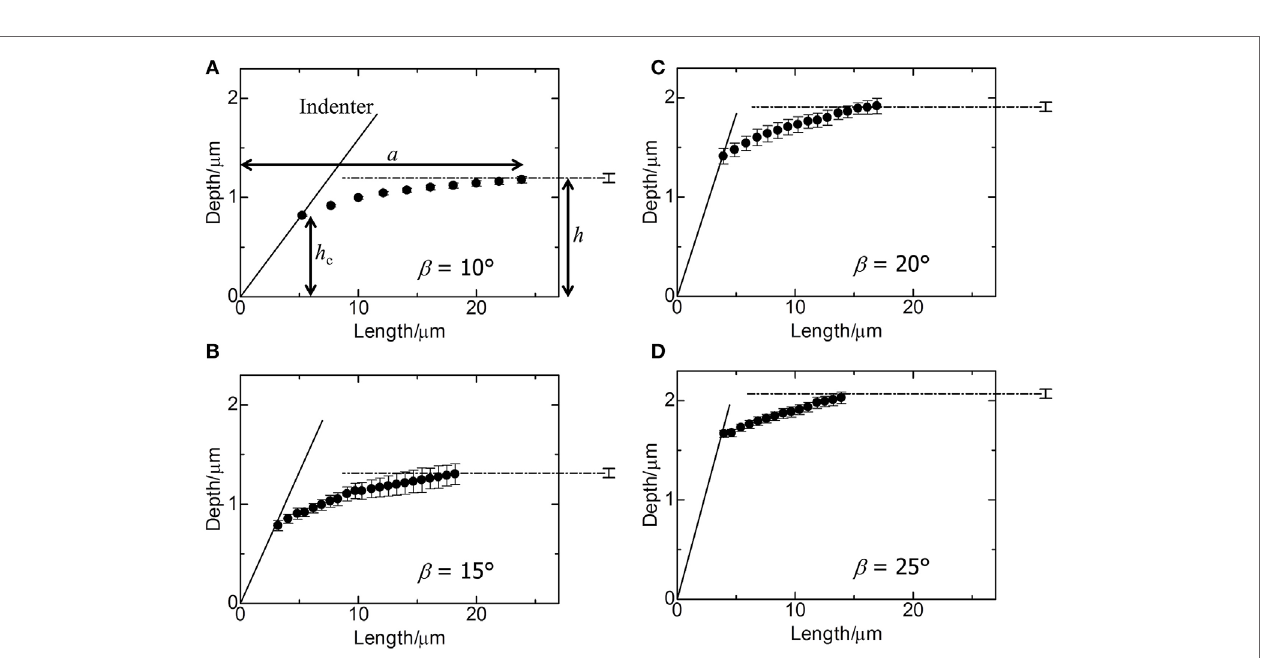
FigUre 6 | surface profiles of soda-lime glass during indentation at a load of 0.5 n . The face angles of indenters are (a) 10°, (B) 15°, (c) 20°, and (D) 25°. The dashed-dotted line in each figure represents the initial profile of the surface before indentation. The solid line in each figure represents the inclined plane of the indenter. Error bars denote ± 1 SD. a , h , and h c in (a) are the radius of the sinking-in region, the penetration depth, and the contact depth, respectively.